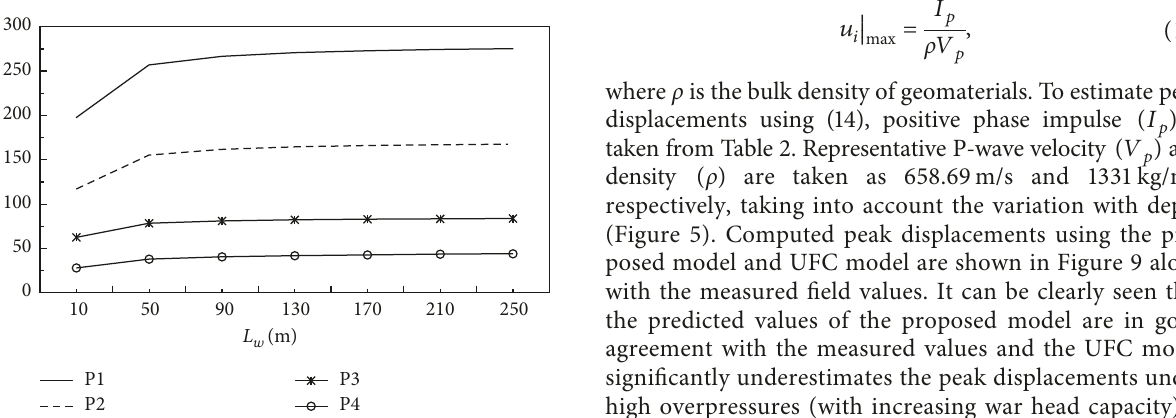
Figure 7: Variation of peak ground displacement with attenuation characteristic length L w